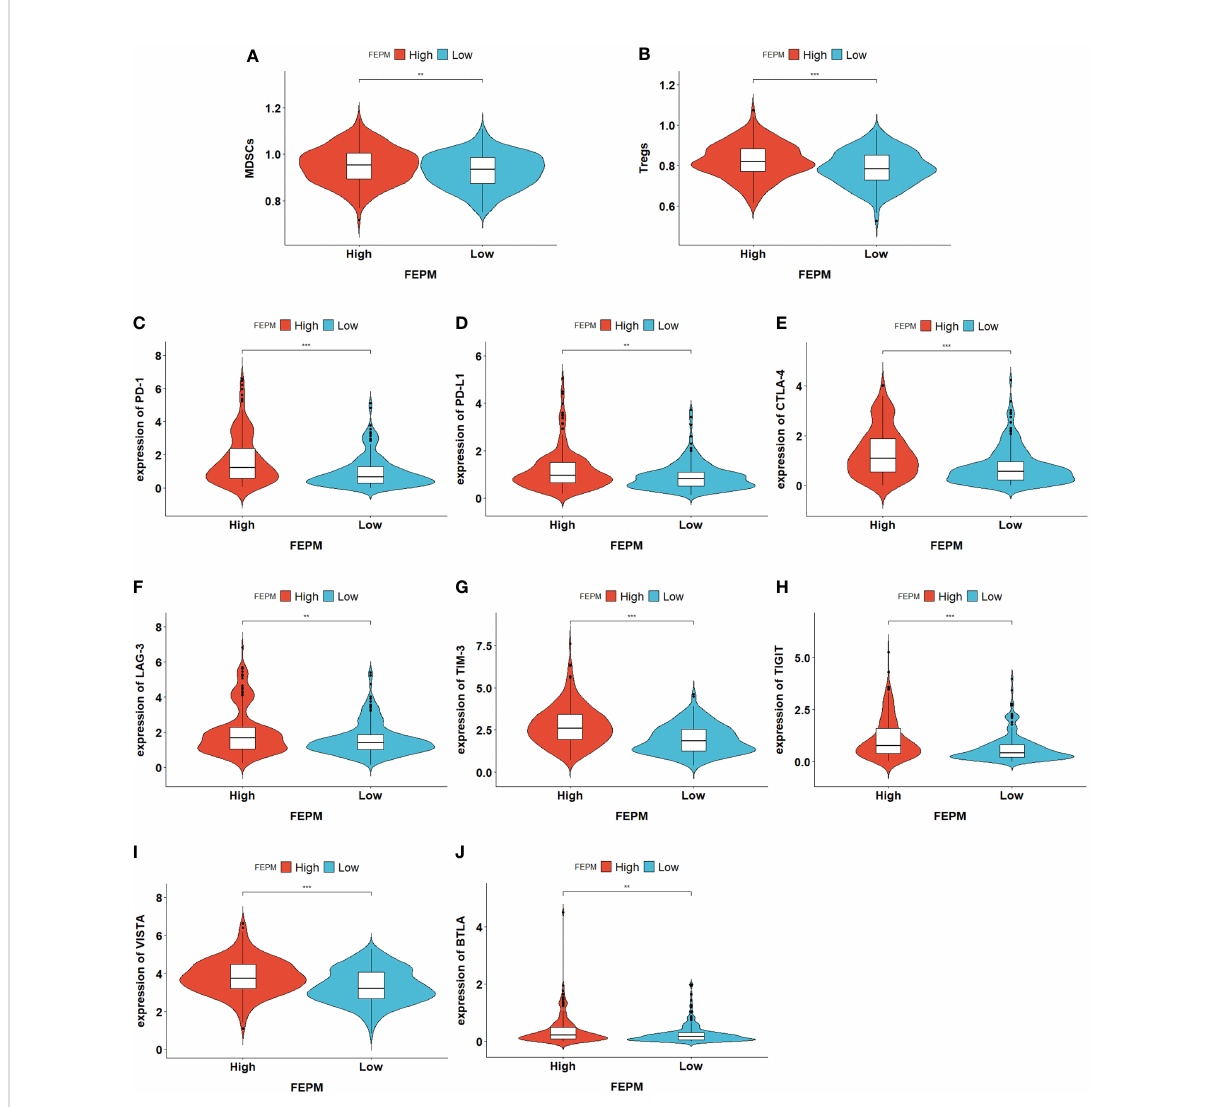
FIGURE 8 (A, B) Violin plots showing the upregulation of immunosuppressive cells (MDSCs and Tregs) in the high-FEPM group based on the ssGSEA enrichment scores of TCGA cohort. (C-J) Violin plots showing the upregulation of a group of immune checkpoints in the high-FEPM group in the TCGA cohort. **p< 0.01; ***p<